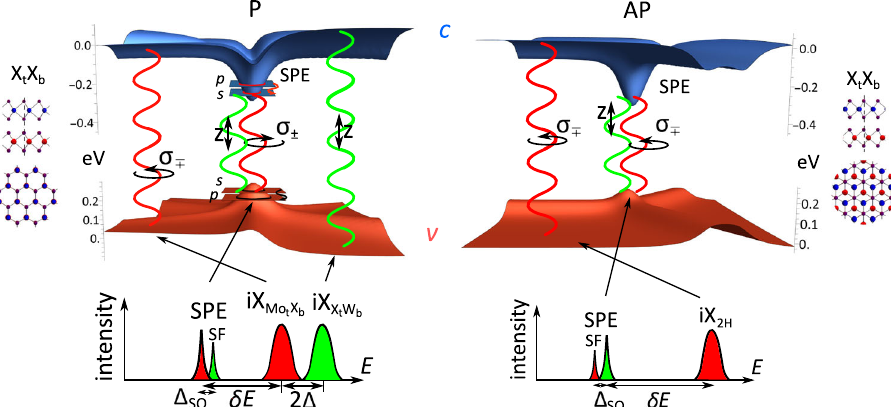
Fig. 3 Self-organized quantum dots and spectral features of SPE and iX. (Top) Conduction ( c ) and valence ( v ) band edge pro fi les in vicinity of X t X b nodes of NoDW in reconstructed P- and AP-MoX 2 /WX 2 bilayers with θ = 0°. Colors of wavy lines encode polarizations of emitted light in ±K-valleys: red for circular and green for z -polarization. Upper/lower subscript of circular polarization ( σ ± or σ ∓ ) indicates helicity of light emitted in + K/ − K-valleys. Left and right bottom panels show sketches of predicted optical spectra in marginally twisted P- and AP-MoX 2 /WX 2 bilayers, respectively.